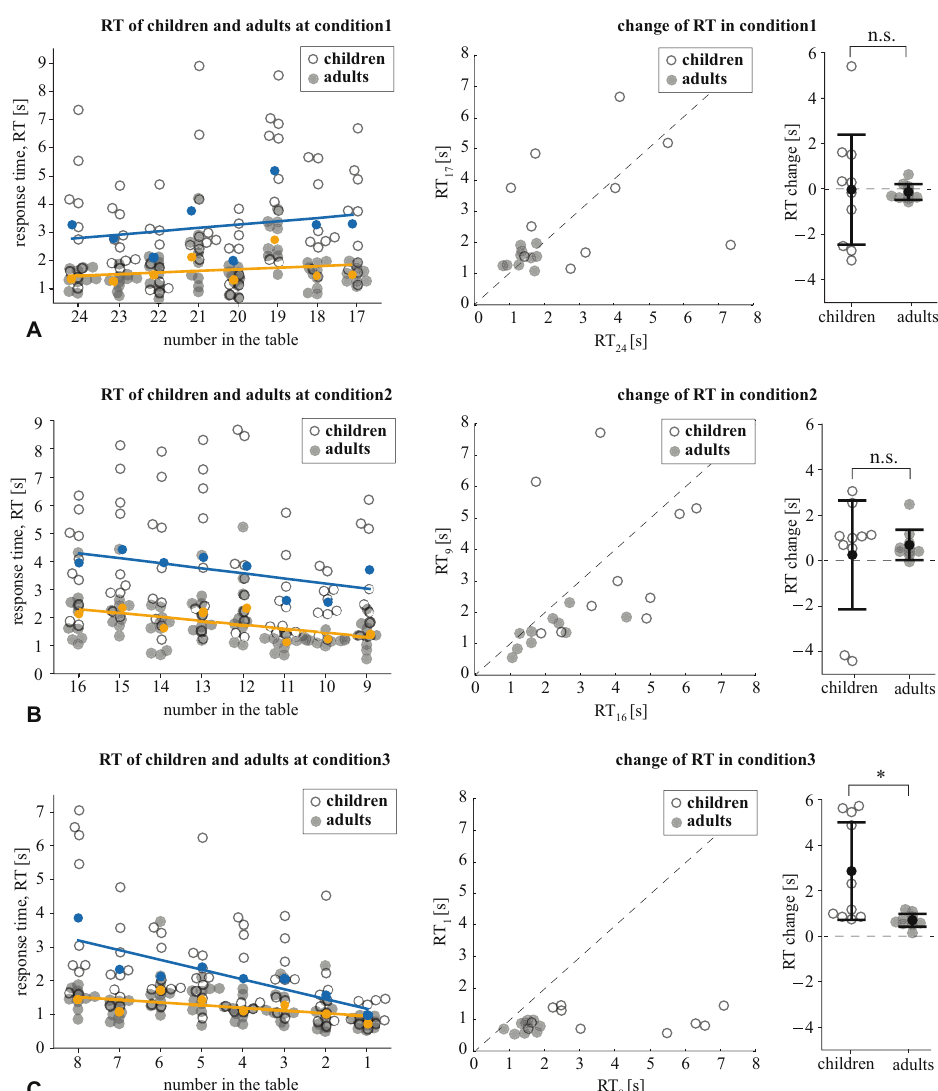
Figure 3. The RT of children and adults under condition1 ( A ), condition2 ( B ), and condition3 ( C ). The left column reflects the RT taken to find each number within the condition. The individual scores of children and adults are shown with their mean values (colored circles). Linear approximation illustrates the way that the mean RT changes within the condition. The middle column shows the individual RTs of children and adults taken to find the first and the last number within the condition. The right column demonstrates the difference between the RT taken to find the last and the first number. Data are shown as the mean ± SD and the individual values for the children and adults ( ∗ p > 0.05 via the Mann–Whitney